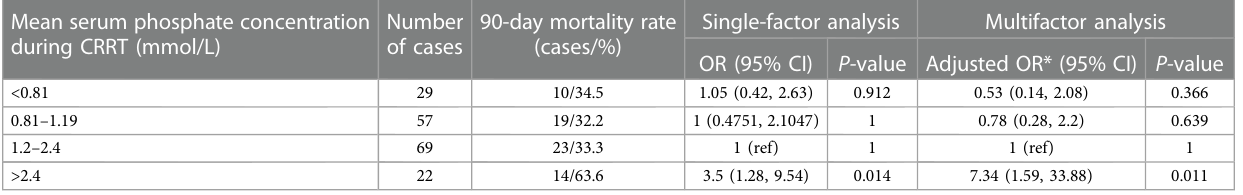
TABLE 3 Relationship between mean serum phosphate concentration during CRRT and 90-day mortality rate. Mean serum phosphate concentration during CRRT (mmol/L)